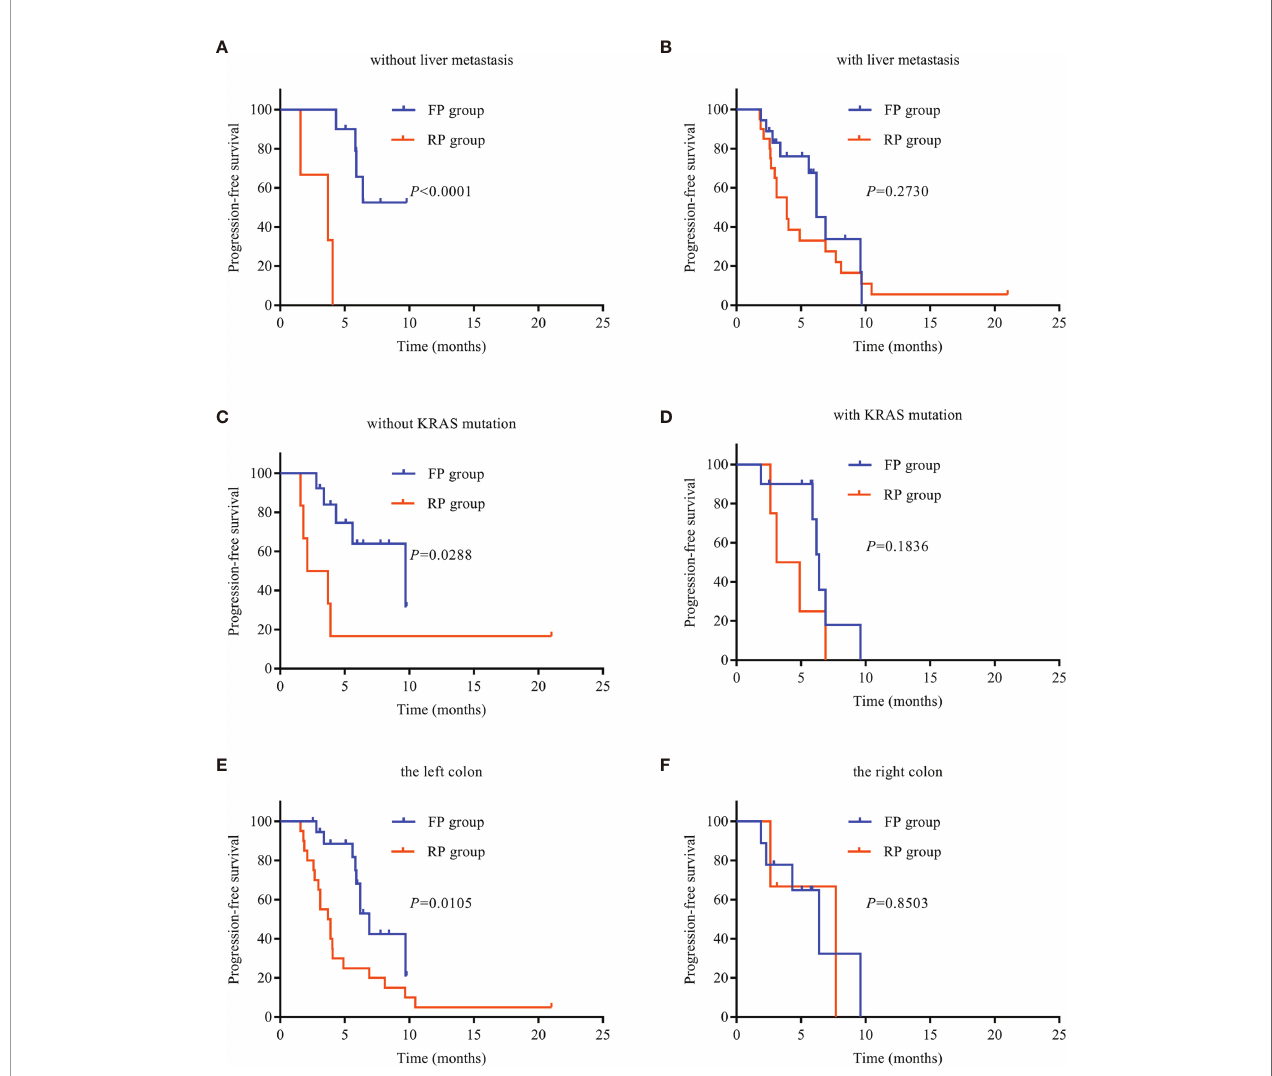
FIGURE 3 | Kaplan – Meier survival curves. (A) PFS in patients without liver metastasis. (B) PFS in patients with liver metastasis. (C) PFS in patients without KRAS mutation. (D) PFS in patients with KRAS mutation. (E) PFS of the left colon. (F) PFS of the right colon. PD-1, programmed death receptor-1; FP, fruquintinib combined with PD-1 inhibitors; RP, regorafenib combined with PD-1 inhibitors; PFS, progression-free